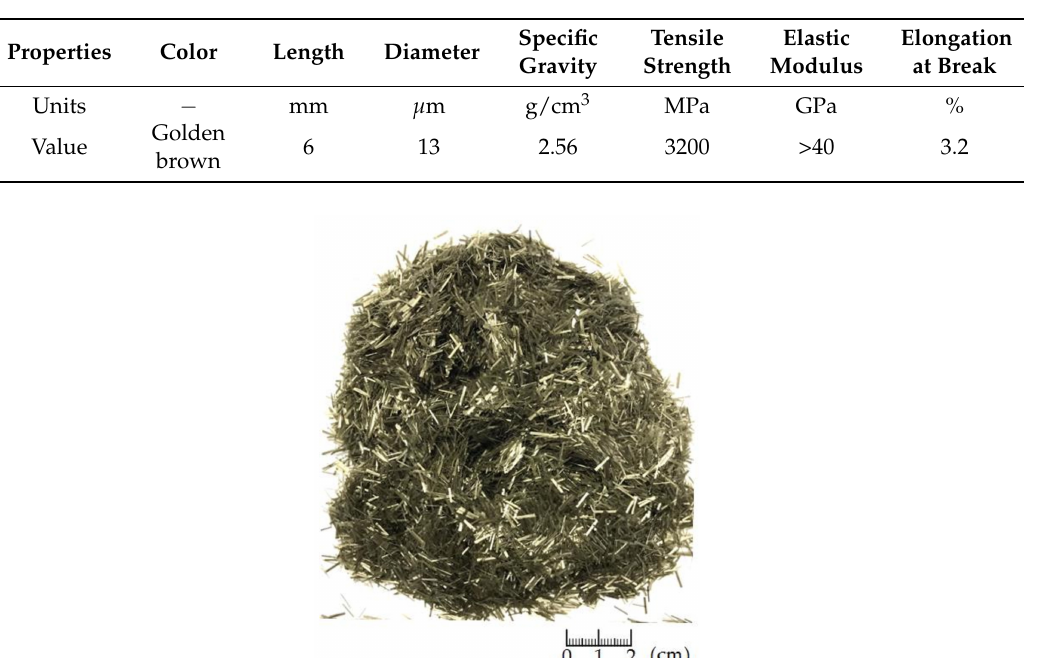
Table 4. Physical properties of the basalt fibers.